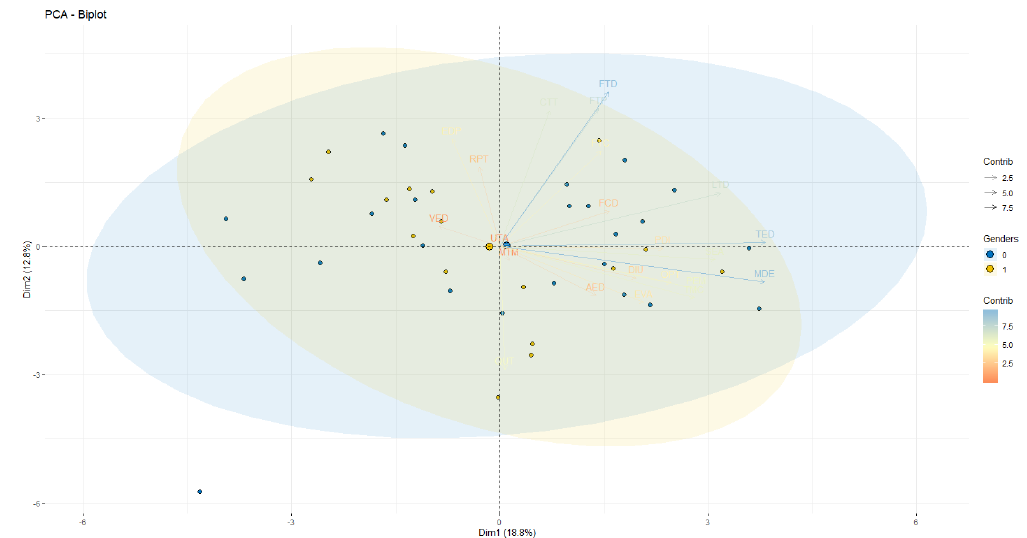
Figure 6. PCA biplot. Score per individual, differentiated by gender.